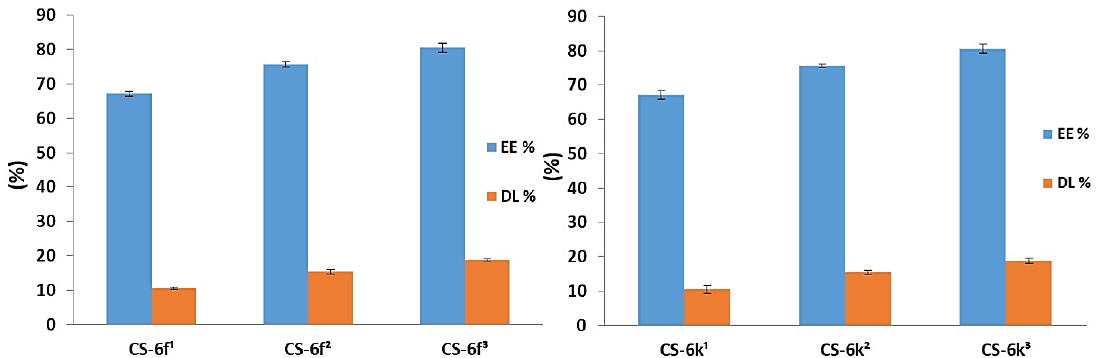
Figure 8. The Entrapment efficiency (EE%) and Drug loading (DL%) for CS–6f and CS-6k ( 1 = 3 mg/mL, 2 = 4 mg/mL, 3 = 5